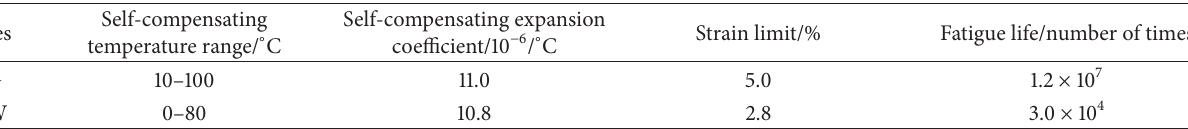
Figure 4: (a) The rig wall during construction phase and instrumented with temperature sensors and strain gauges between GHB mortar and reinforced base coat. (b) Temperature sensor. (c) Strain gauge. Table 3: Performance indexes of KFG/KFW.